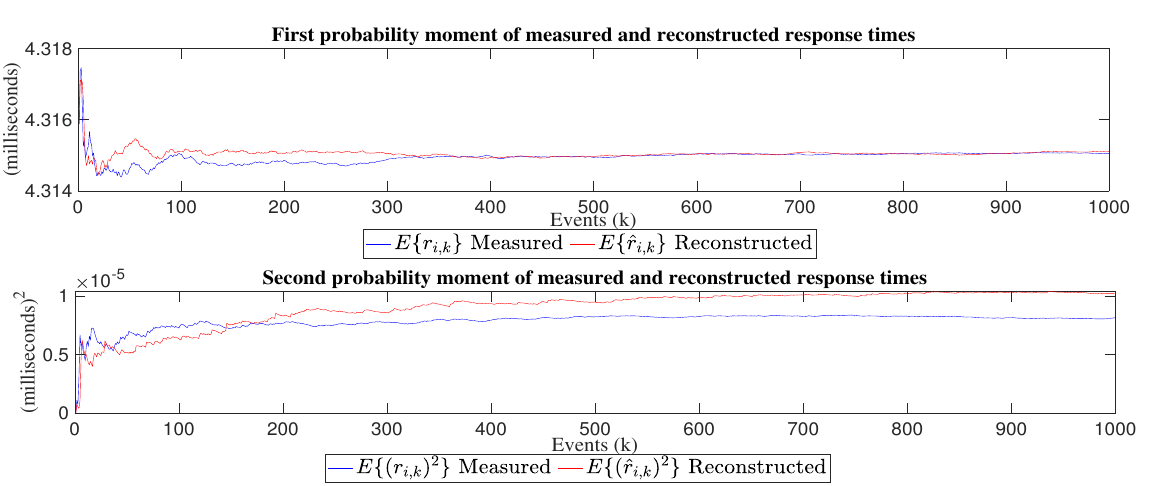
Figure 11. First and second probability moment of reconstructed ˆ r i , k and measured response times r i , k for the 32 × 32 matrix inversion